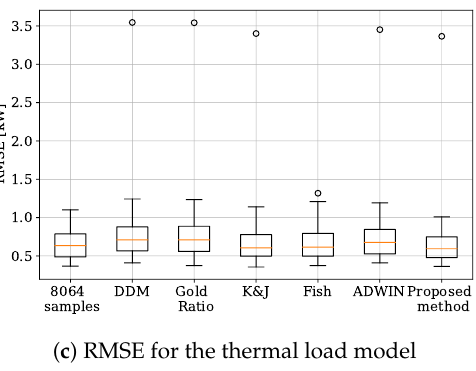
Figure 8. RMSE dispersion in the spring